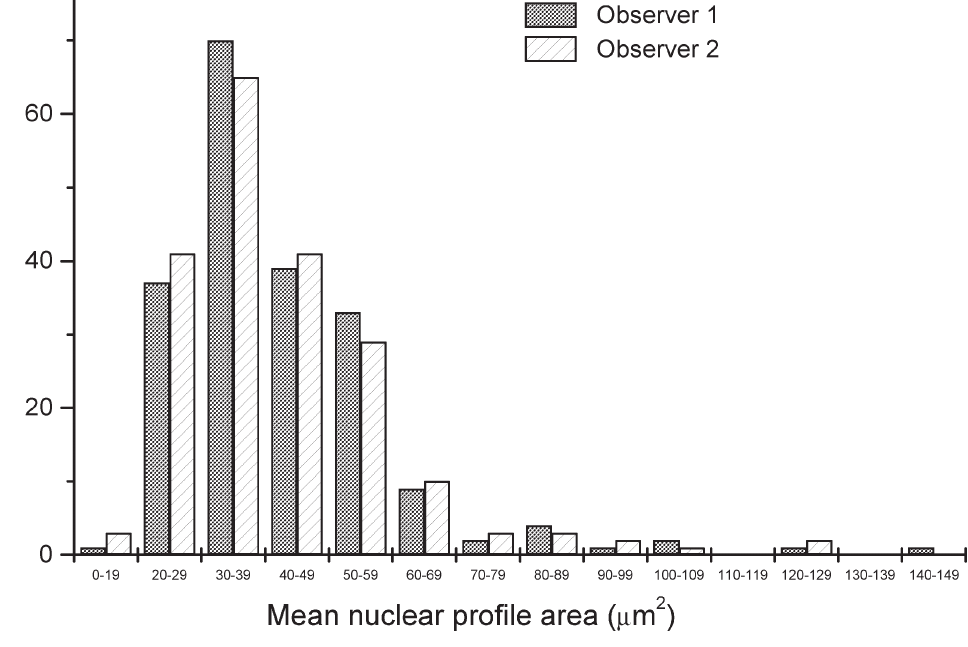
Fig. 1. Distribution of the mean nuclear profile area in the whole material of 192 breast cancer samples. The consistency of the measurements is excellent with the average of the mean nuclear profile areas 41.9 µ m 2 (median 36.9 µ m 2 ) for both observers.